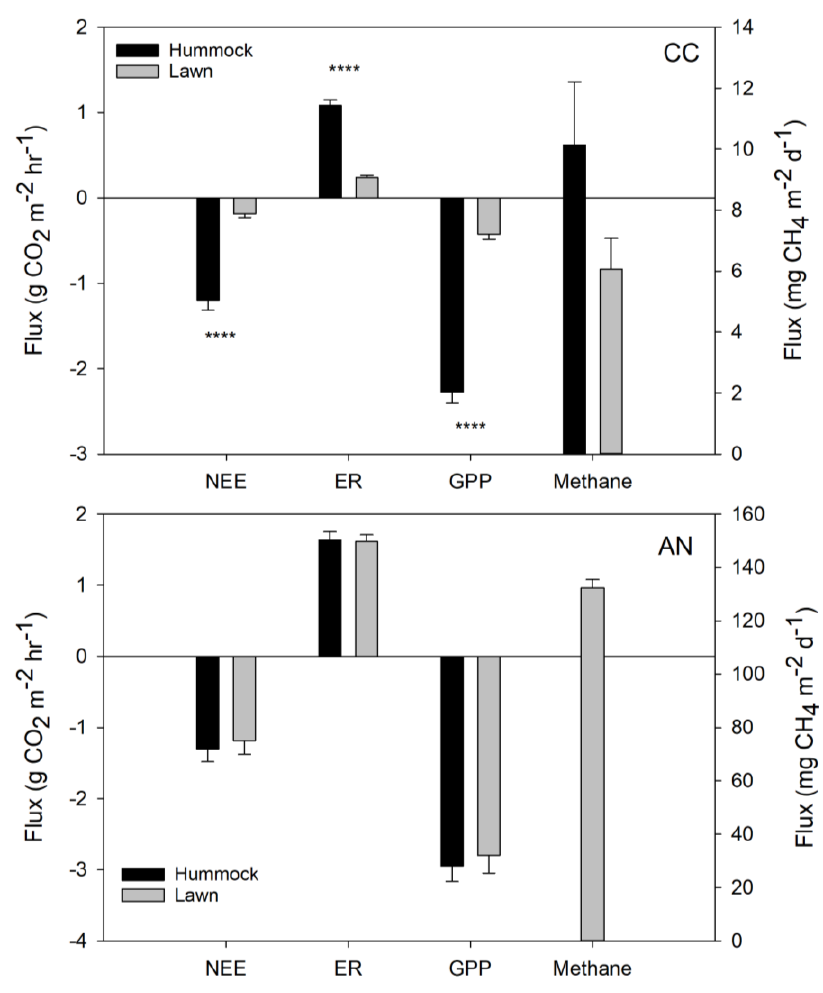
Figure 4: Mean net ecosystem exchange (NEE), ecosystem respiration (ER), gross primary production (GPP) and methane flux by microtopography (hummock and lawn) for all plots at Cayambe Coca (CC) and Antisana (AN). Error bars indicate one standard error. Asterisks indicate significant differences between hummock and lawn. For carbon dioxide (CO ) components (g CO m -2 hr -1 ), negative values represent uptake 2 2 by the ecosystem. For methane (mg CH m -2 hr -1 ), positive values represent loss from the ecosystem. No 4 data shown for CH fluxes in hummocks at 4